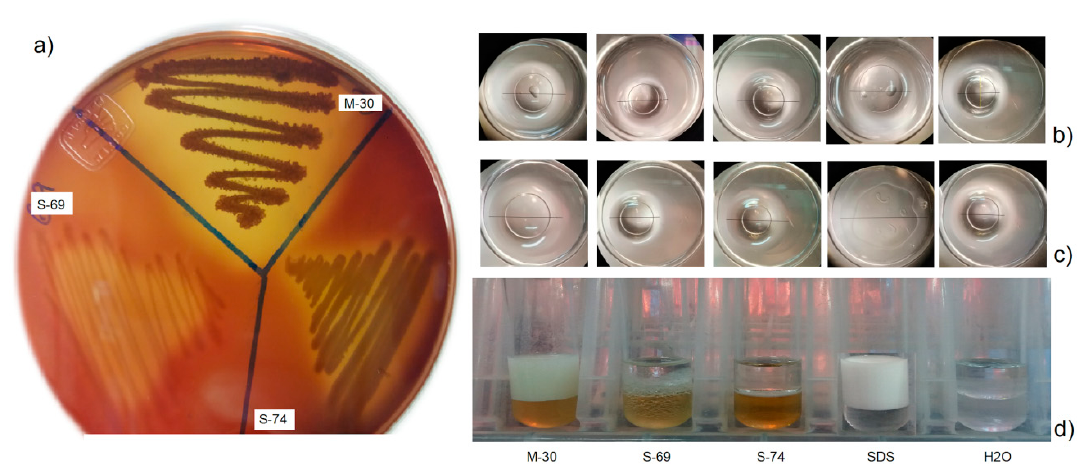
Figure 1. Evaluation of the effect of biosurfactants of marine bacteria isolated from the Gulf of California. Supernatants of Bacillus niabensis (My-30), Bacillus niabensis (S-69), Ralstonia sp. (S-74), (controls: SDS 10% and H 2 O). ( a ) Hemolytic activity, ( b ) drop collapsing in olive oil, ( c ) drop collapsing in mineral oil and ( d ) emulsification properties at 24 h.